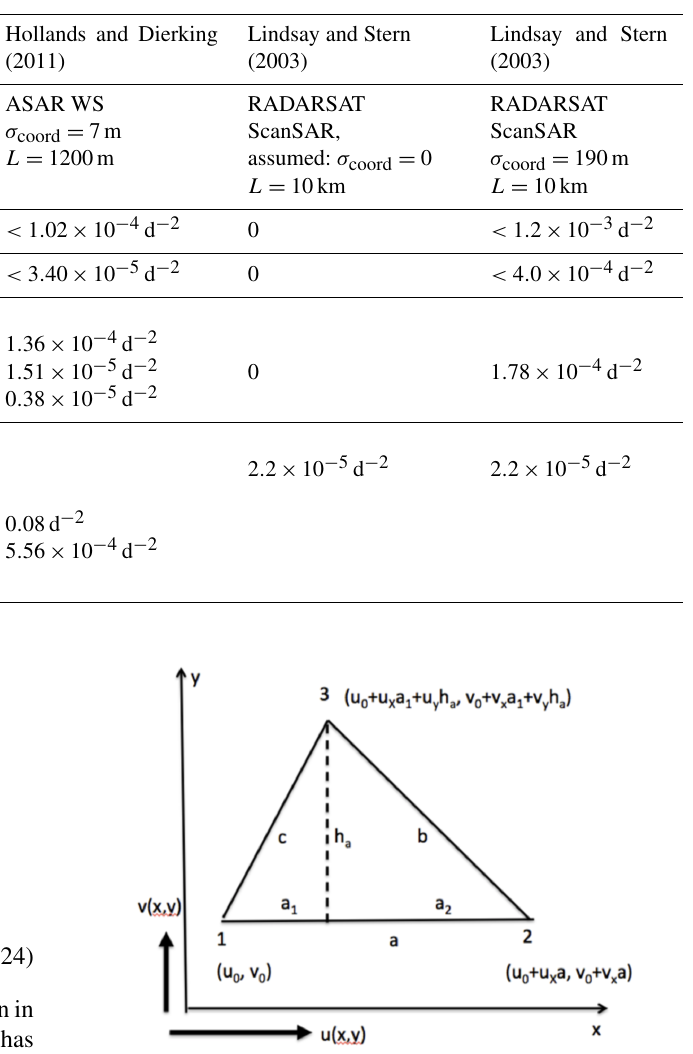
Figure 4. Uncertainty of divergence for a triangle in a spatially varying velocity field with gradients u x , u y , v x , v y . The height h a is 2 A/a ( A can be calculated from Heron’s formula), and a 1 = c 2 − h 2 a . Side a is the base of the